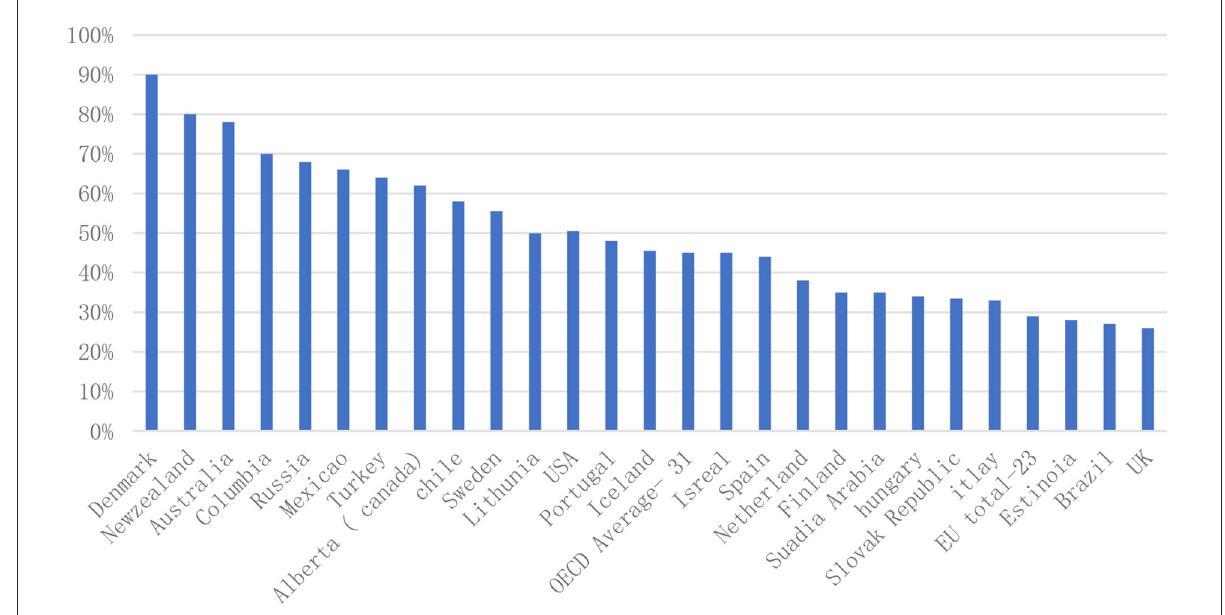
FIGURE5 Percentage of secondary education teachers who “frequently” or “always” have students use ICT for projects and classroom